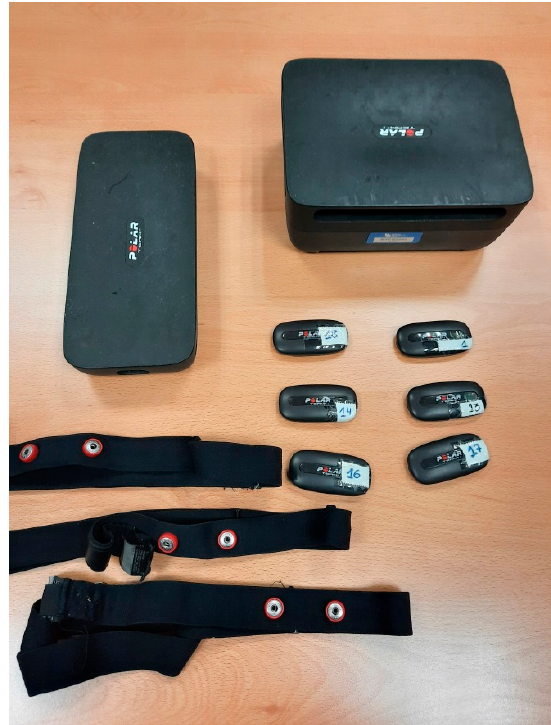
Figure A2. Polar Team 2 device.